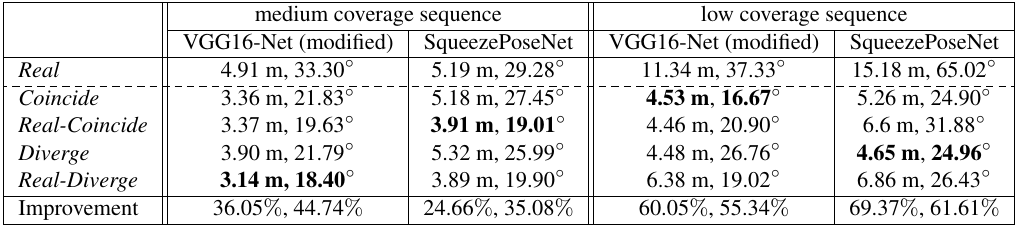
Table 2: Position and rotation evaluation errors on the medium and low coverage sequence . The improvement corresponds to the best result per CNN, which is marked in bold.